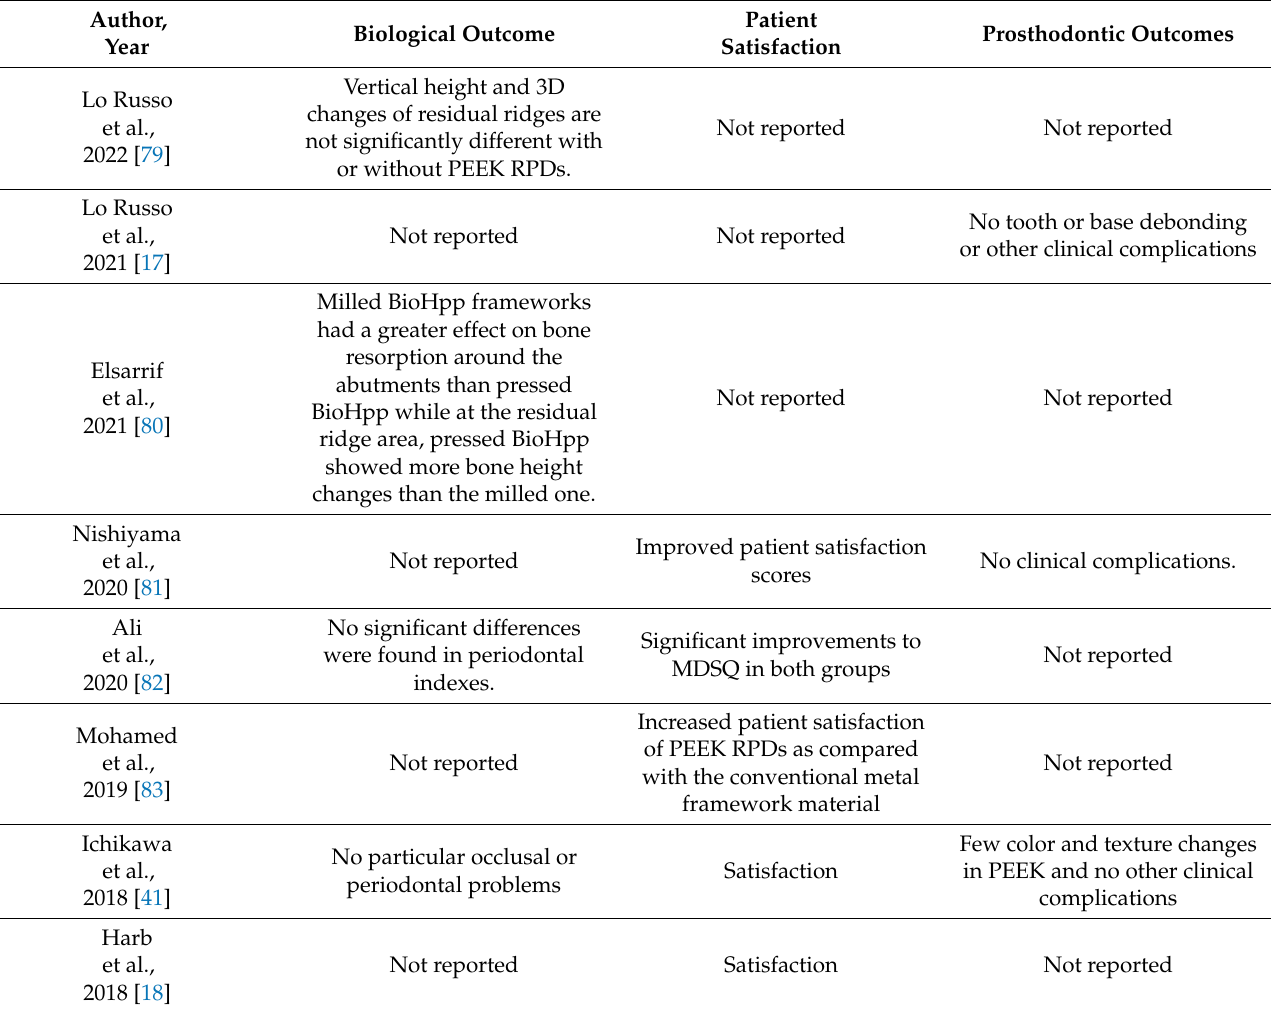
Table 2. Clinical outcome of clinical studies on removable partial dentures. PEEK: polyetheretherke- tone; CoCr: cobalt-chromium; MDSQ: McGill Denture Satisfaction